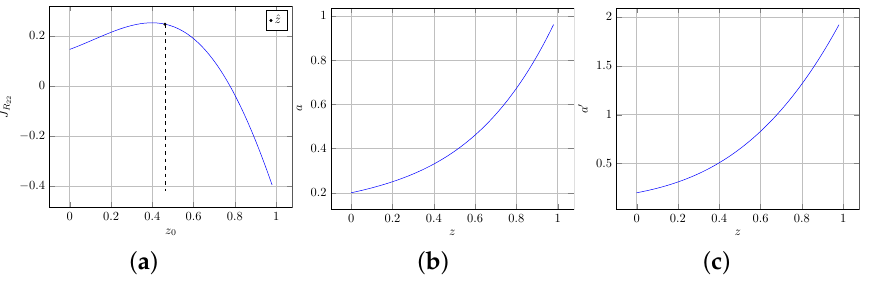
z 0 for 0 1 and ˆ f 0 = σ / ( r 12 ≤ ≤ z < 1. Parameters: n = 5, r = 3, and σ = ≤